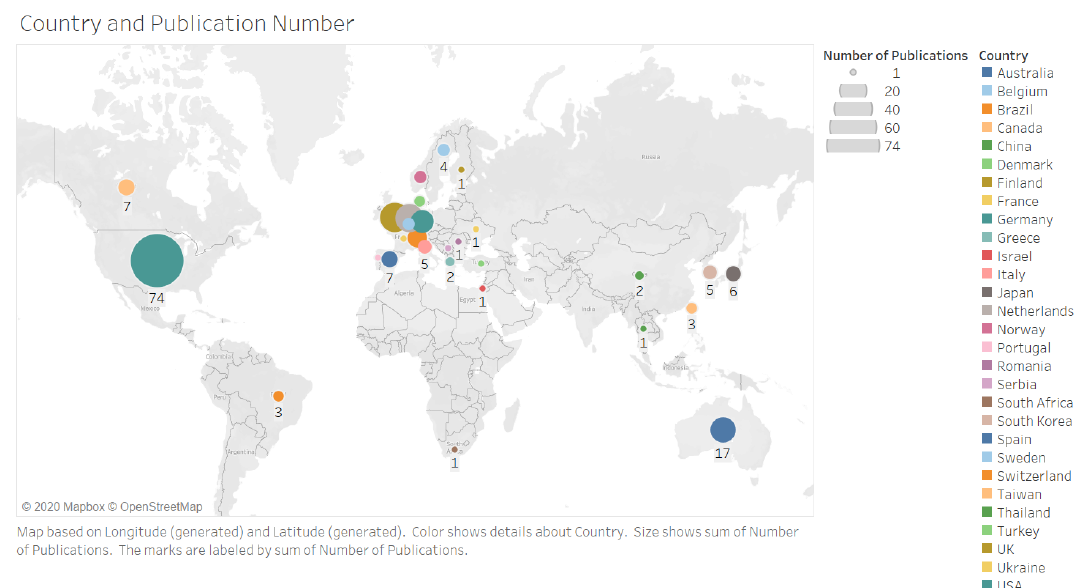
Figure 3. Geographical distribution of studies by country of origin where work was conducted. Studies originated from a total of 29 different countries.